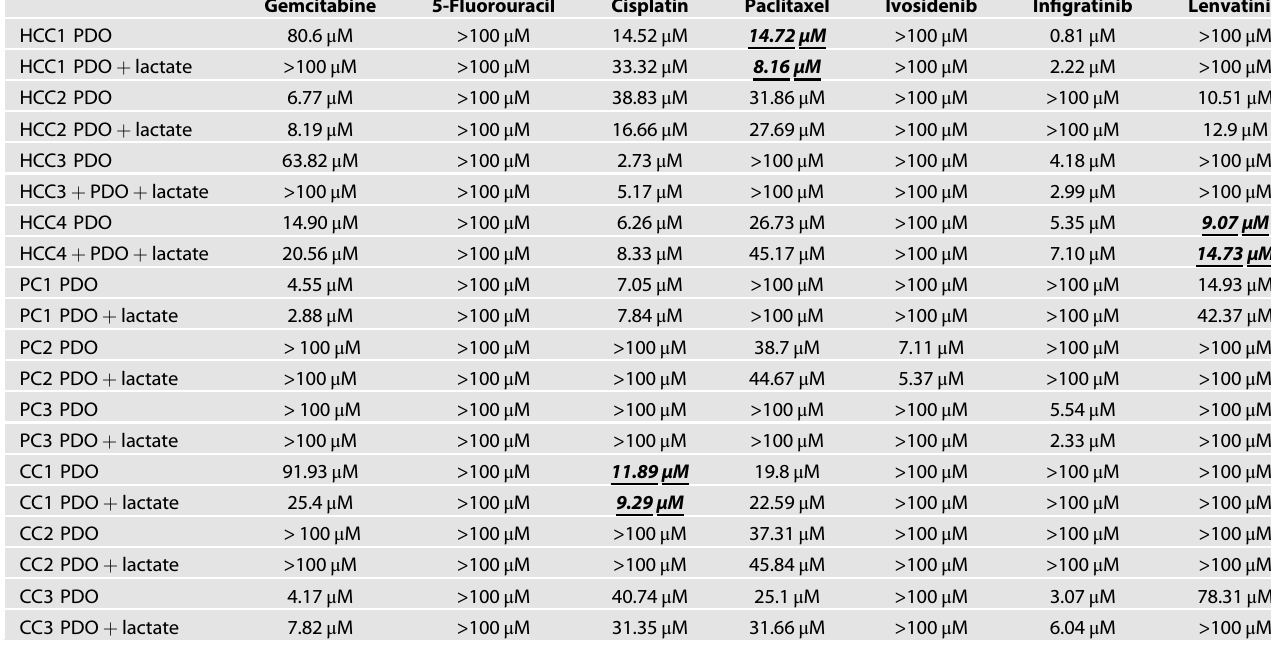
Table 1. IC 50 of seven therapeutic drugs in PDOs with or without